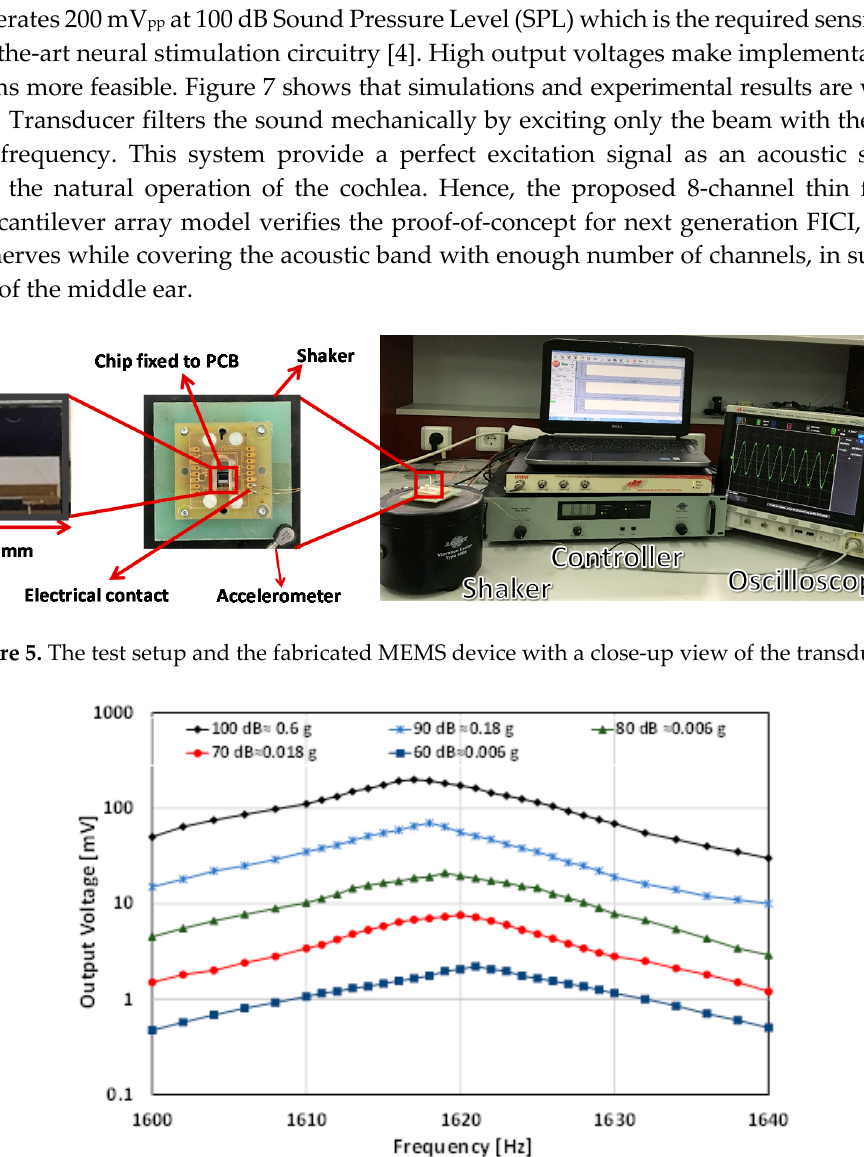
Figure 6. Frequency response of device at different umbo vibration levels.